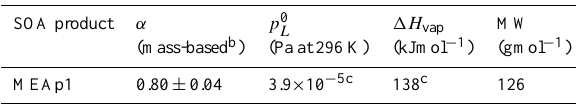
Table 4. Parameters of the one-product model for SOA a formed in reaction